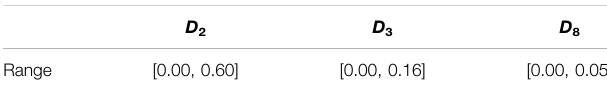
TABLE 1 | The ranges of signi fi cant Fourier descriptors for pore contours.